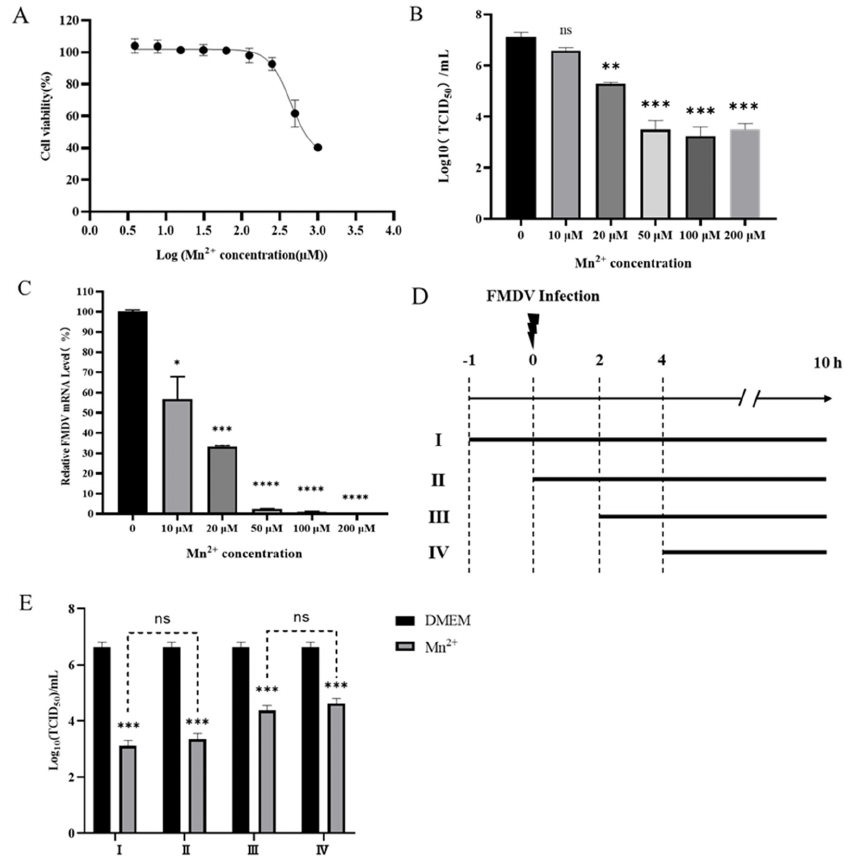
Figure 1. Antiviral activity of Mn 2+ against FMDV in PK15 cells. ( A ) PK15 cells were incubated with 2-fold serial dilutions of Mn 2+ . After 72 h of culture, cell viability was measured and compared with the untreated cell control group. ( B ) PK15 cells were treated with 0, 10, 20, 50, 100, and 200 μ M Mn 2+ , respectively, and infected with FMDV at MOI 1. The cells and supernatants were collected 12 h after FMDV infection, the viral titers were detected by TCID 50 , and the virus copy number was detected by real-time RT-PCR ( C ). ( D ) Schematic diagram of the time course of the Mn 2+ addition experiment. ( E ) PK15 cells were treated with 50 μ M Mn 2+ at 1 h before FMDV infection (I), at the time of FMDV infection (II), 2 h (III), and 4 h (IV) after FMDV infection. The cells were infected with FMDV at MOI of 1 for 1 h. In each step, the cells were washed twice with PBS. The supernatants were collected at 10 h post-FMDV infection and virus titration was performed. Error bars indicate the standard deviation (SD) from the mean. A t -test was performed to identify statistically significant differences. *, p < 0.05; **, p < 0.01; ***, p < 0.001; ****, p < 0.0001.